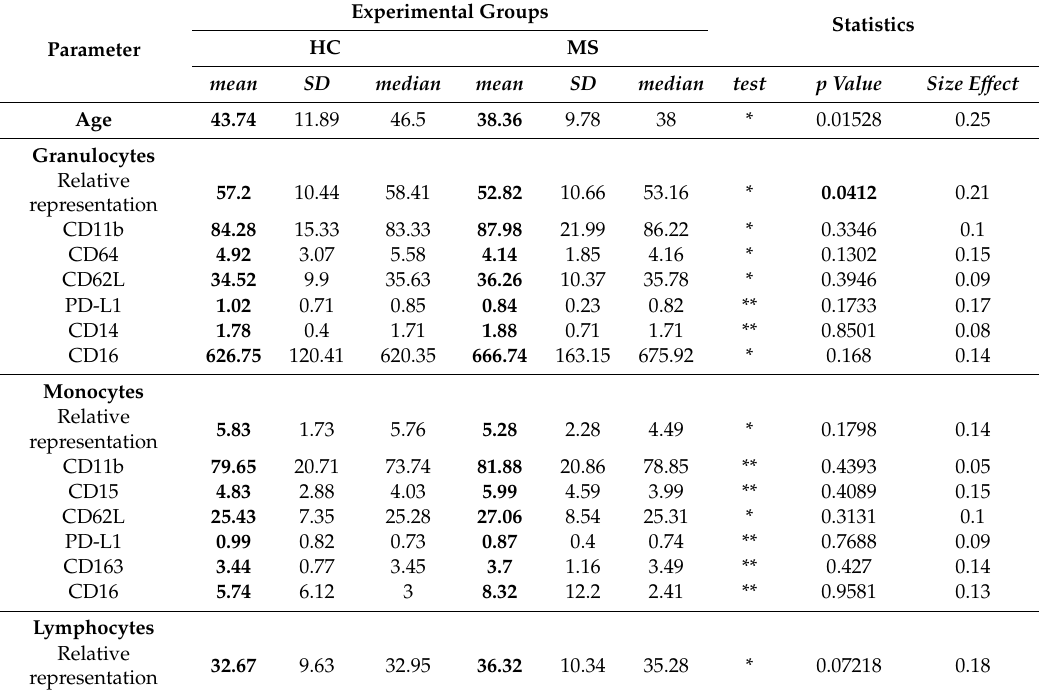
Table 1. Descriptive statistics for matched multiple sclerosis (MS) patients and healthy controls